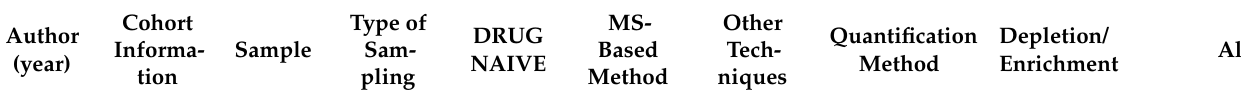
Table 2. Proteomic studies of bipolar disorder and biomarkers discovery using MS-based method in human peripheral fluids. The proteins identified as altered are represented by their accession number as described in UniProt (the corresponding protein name and entry name are described in Supplementary Information, Tables